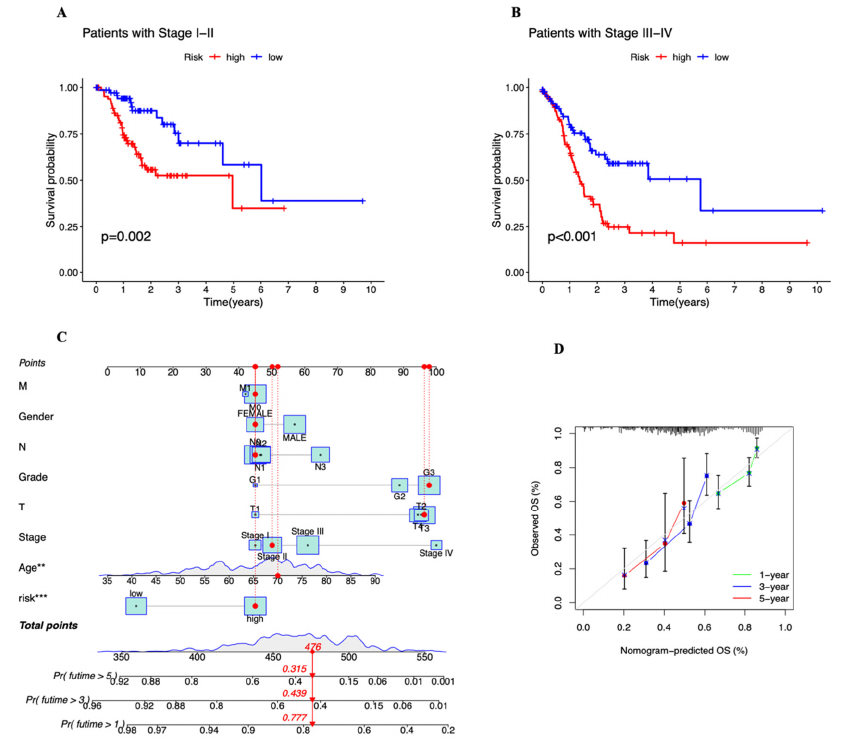
Figure 7. ( A , B ) Kaplan–Meier curves depicting subgroup survival analysis stratified by stage. p < 0.05, statistically significant. ( C ) The nomogram for risk score could predict the probability of sur- vival based on the total points. ( D ) The calibration curves test the agreement between actual and predicted outcomes for STAD patients’ overall survival at 1-year (green line), 3-year (blue line), and 5-year (red line). * p < 0.05, ** p < 0.01, *** p < 0.001.